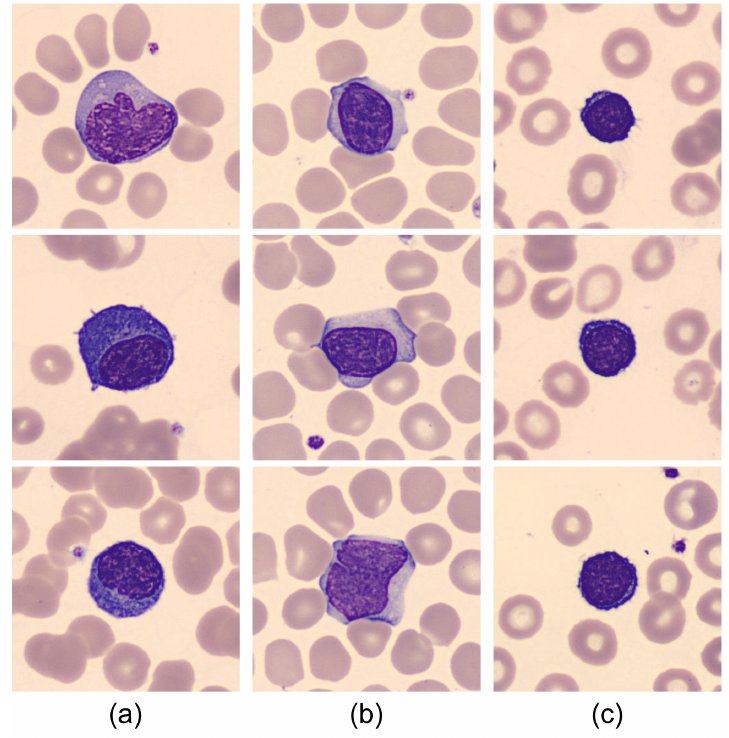
Figure 2. Examples of images of cells circulating in the blood of subjects involved in this study: ( a ) COVID-19 RL that have been found in some of the patients with COVID-19 infection; ( b ) Classic RL found in other viral infections; ( c ) Normal lymphocytes from healthy subjects. These images have been obtained from patients involved in this